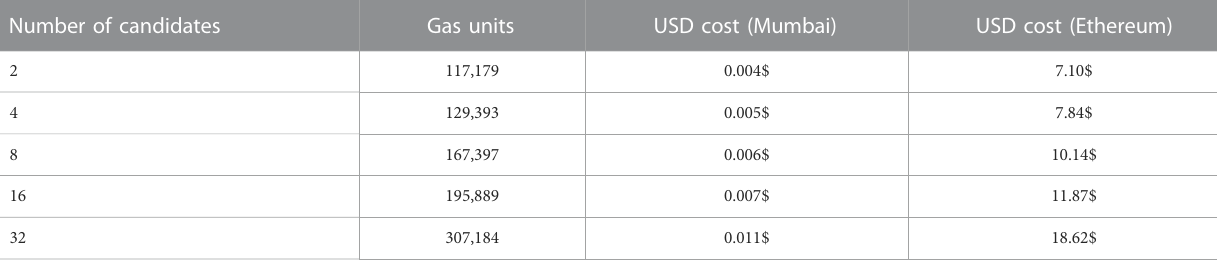
TABLE 2 Costs for computeWinner method. Average price per gas unit of 43